Question: What style of plot is this figure drawn as?
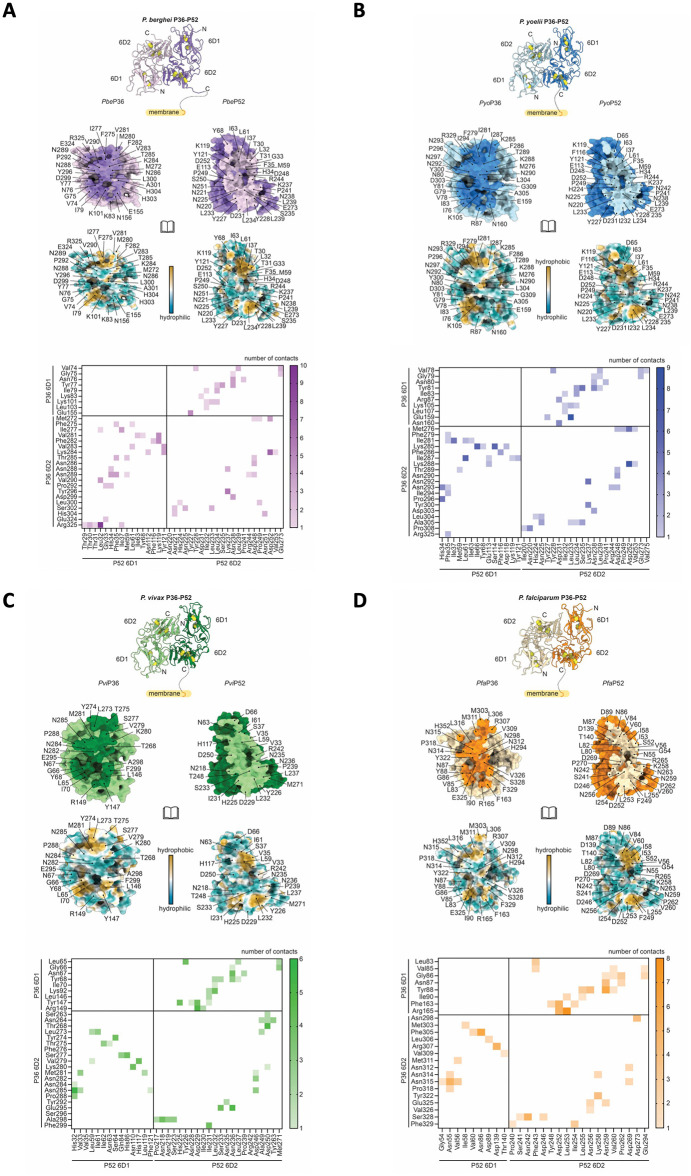
Answer: heatmap